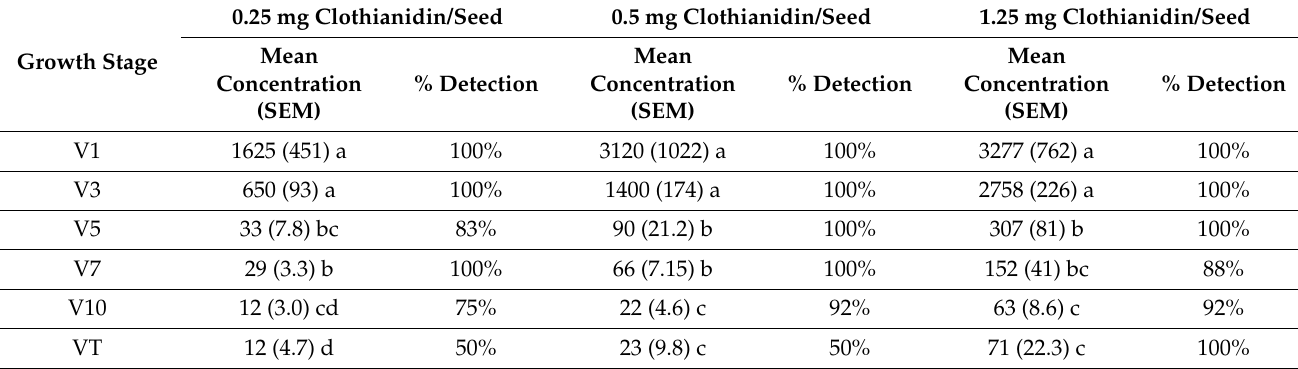
Table 1. Mean concentration (ng/g) and percent detection of clothianidin detected in corn leaf tissue at each growth stage for each clothianidin seed treatment across all locations.